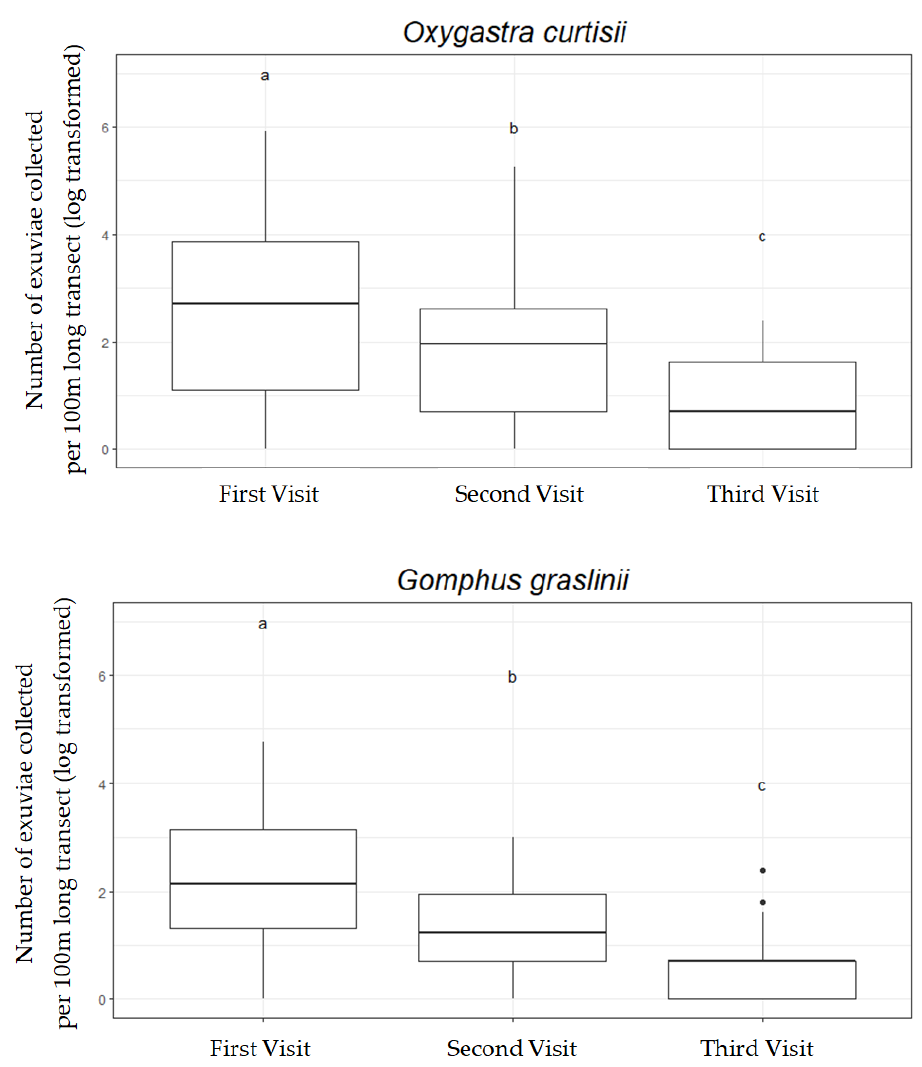
Figure 7. Abundance of exuviae of Gomphus graslinii and Oxygastra curtisii collected along 100 m-long transects ( n = 98 transects) during the first, second, and third visits. Abundances are log-transformed. Box plots indicate median, range, and first and third quartiles. Points indicate outliers. Significant differences are indicated by different letters.